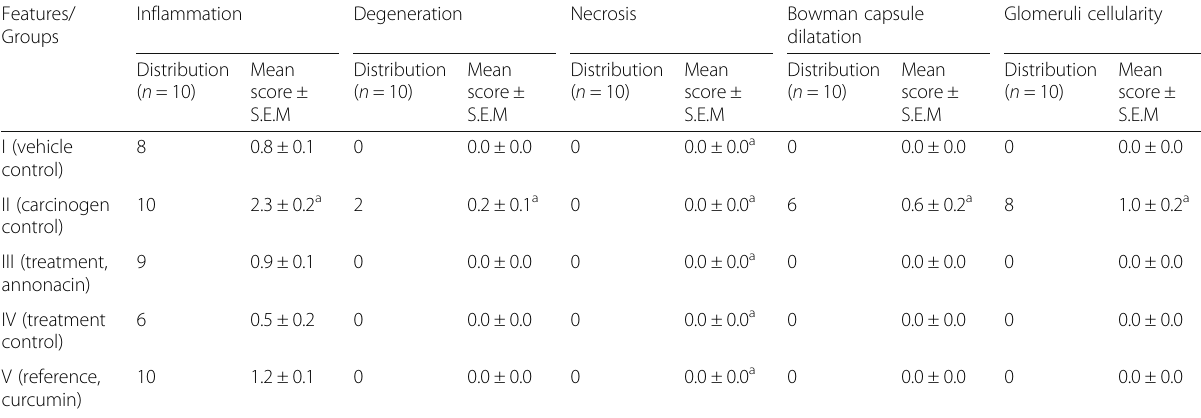
Table 3 The distribution and mean scores of histopathological changes due to toxicity in mice kidney of each group Features/